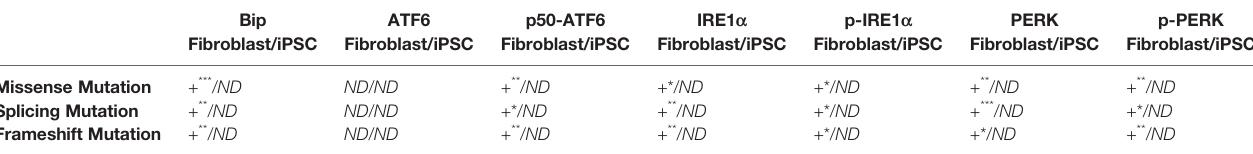
TABLE 1 | Expression of Each ERS Marker in Different Cell Types and Mutations. Bip ATF6 Fibroblast/iPSC